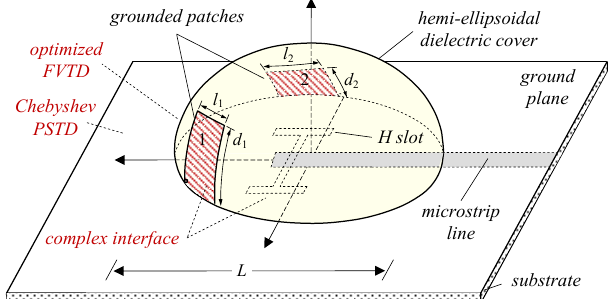
Figure 14: A hemi-ellipsoidal H -slot dielectric-loaded an- tenna with two patches. Modeling regions: complex-interface schemes for the patches, the slot and the micro-strip line, op- timized FVTD technique for the cover and the open space, and PSTD algorithm for the substrate.